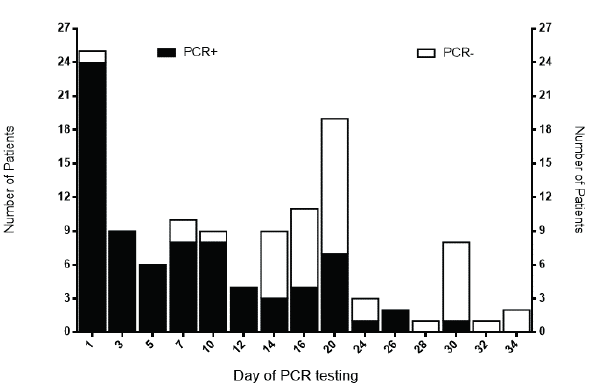
Figure 2. Olfactory impairment and evolution of SARS-CoV-2 infection. Venezuelan Olfactory Test was performed until Olfactory Index Grading reached normosmic value (8-10). A. Each bar represents number of sub- jects at specific grade of olfaction. Bar symbol represents day of testing (Day 1